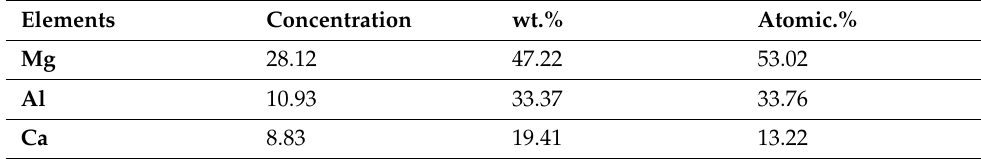
Table 1. EDS elemental analysis of